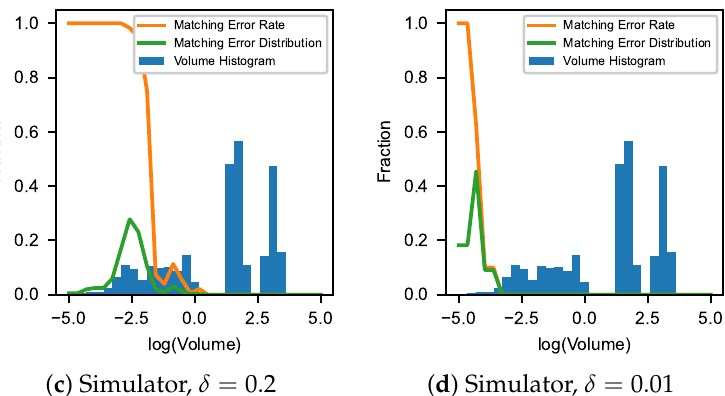
Figure 3. Histograms of the volumes of the facets of the convex polytopes in 4D, the relative distribution of matching errors and the error rate at a given volume and for different δ . ( Top ): Voronoi problem. ( Bottom ): Simulated quantum devices.